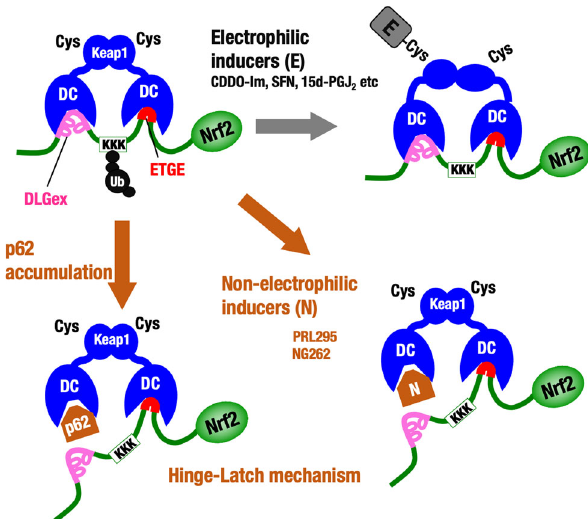
Fig. 7 The Hinge-Latch model updated. Pharmacological Keap1 – Nrf2 PPI inhibitors disrupt the DLGex – Keap1 interaction preferentially to the ETGE – Keap1 interaction, conforming the concept of the Hinge-Latch model. Similarly, p62 accumulation disrupts the DLGex – Keap1 interaction preferentially and activates Nrf2, conforming to the Hinge-Latch model and supporting the notion that this mechanism operates in physiological as well as pathological contexts. In contrast, electrophilic Nrf2-activating compounds activate Nrf2 without disrupting the Neh2 – Keap1 interaction, implying that these Keap1 thiol-modifying chemicals utilize mechanisms distinct from the Hinge-Latch